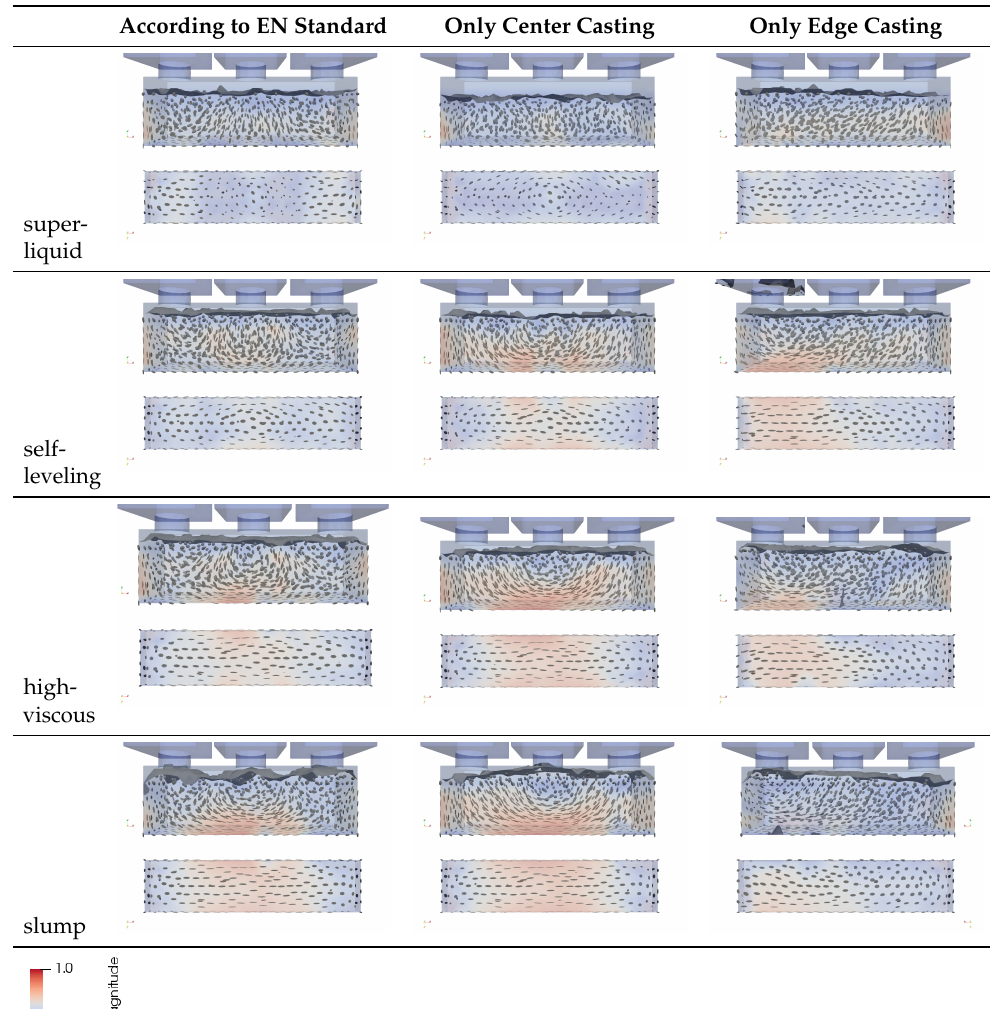
Table 3. Comparison of fiber orientations for different flowabilities and casting points. The ellipsoidal glyphs represent the fiber orientation distribution: an isotropic distribution is represented by a spher- ical glyph, a distribution with well aligned fibers is shown by a cigar shaped glyph. An additional hint is given by the colors from blue to